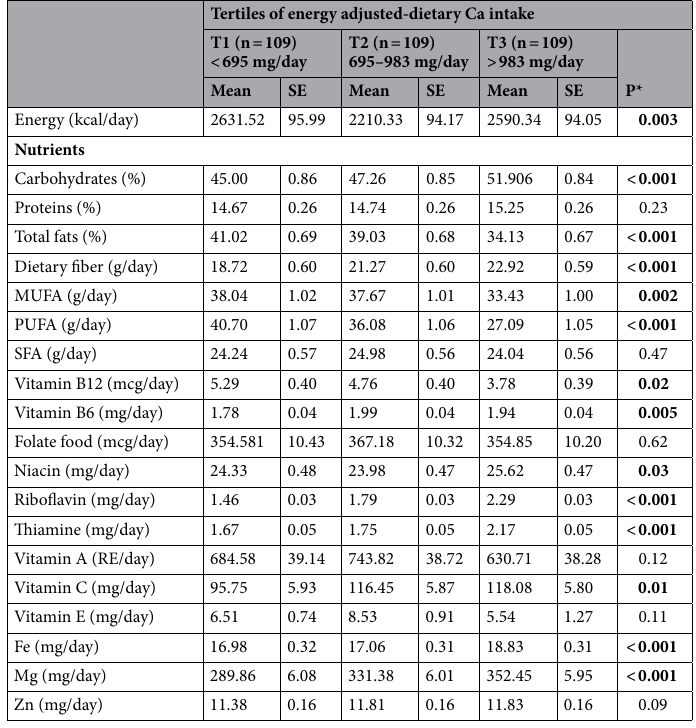
energy intake, which was only adjusted for age and sex by using ANCOVA.